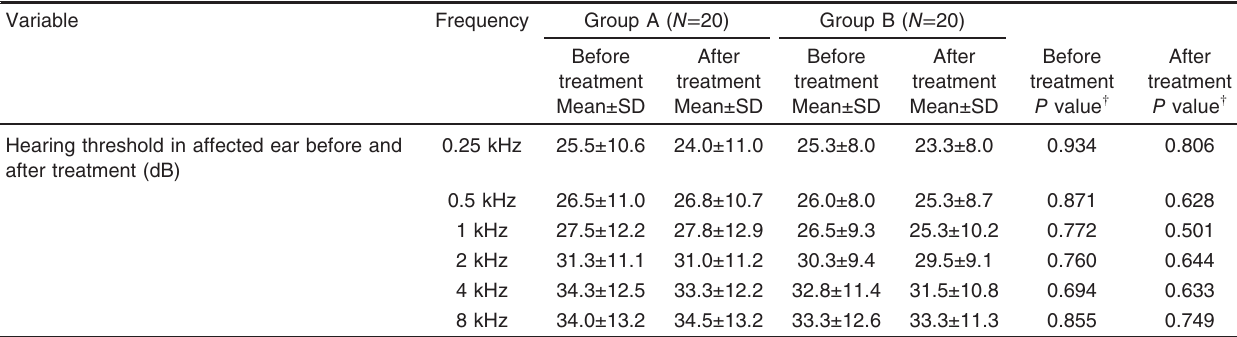
After Before After Before After treatment treatment treatment treatment treatment